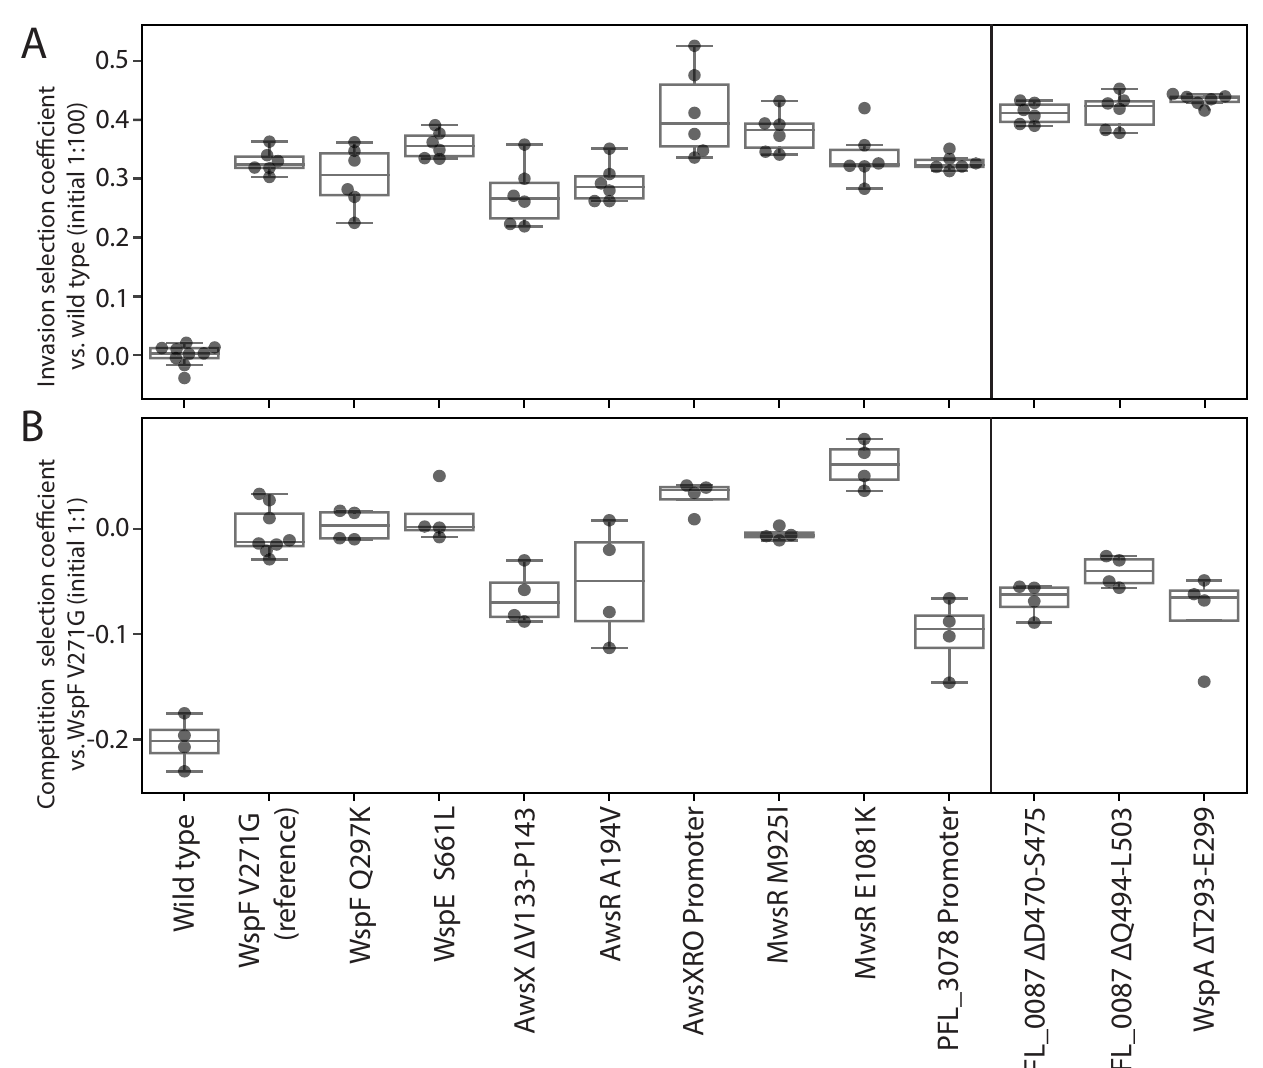
Fig 5. Fitness of reconstructed P . protegens Pf-5 WS mutants was measured in pairwise competitions. ( A ) Invasion fitness was measured relative a dominant ancestral wild type strain with a 1:100 initial ratio. All mutations were adaptive and can increase from rare to colonize the air-liquid interface. Six independent competitions were performed for each pair. ( B ) Competition fitness was measured relative the most common WS mutant (WspF V271G) in a 1:1 initial ratio to compare the fitness of different WS mutants and the alternative phenotypic solutions. Four independent competitions were performed for each